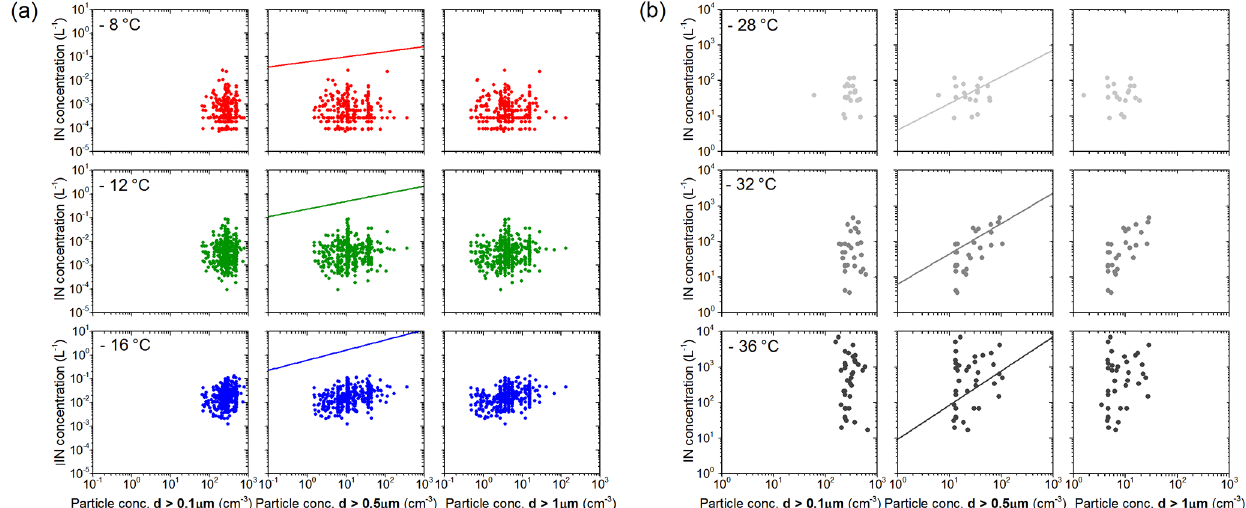
Figure C1. (a) The 24 to 72h average IN concentration from filter experiments on the y axis versus the total concentration of particles with diameters larger than 0.1, 0.5, 1µm on the x axis; (b) 30min average IN concentration from SPIN experiments versus the total concentration of particles larger than 0.1, 0.5, 1µm. IN concentration predicted by the DeMott et al. (2010) parametrization is given in the center row of both